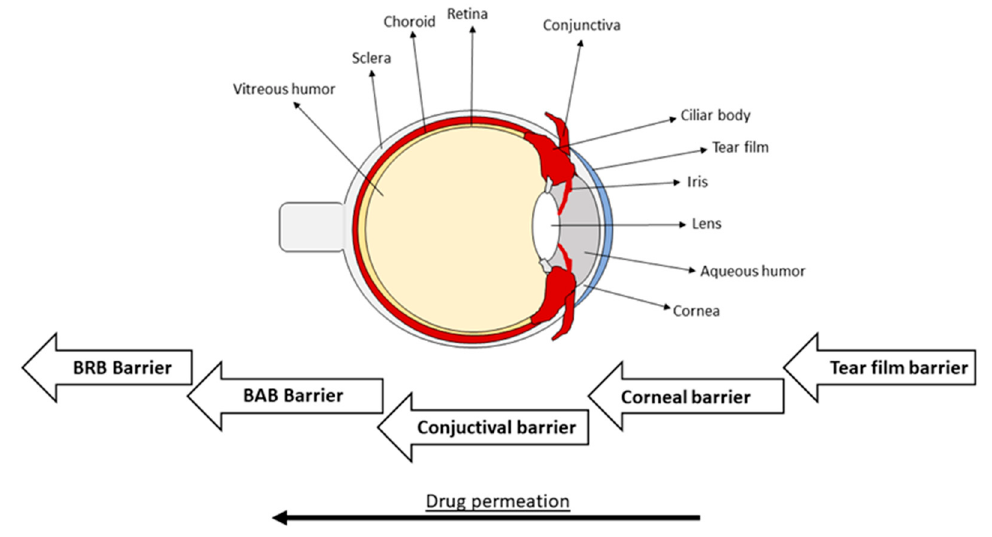
Figure1. Figure 1. Structure of eye and physiological barriers (BRB: Blood–retinal barrier, BAB: Blood–aqueous barrier).